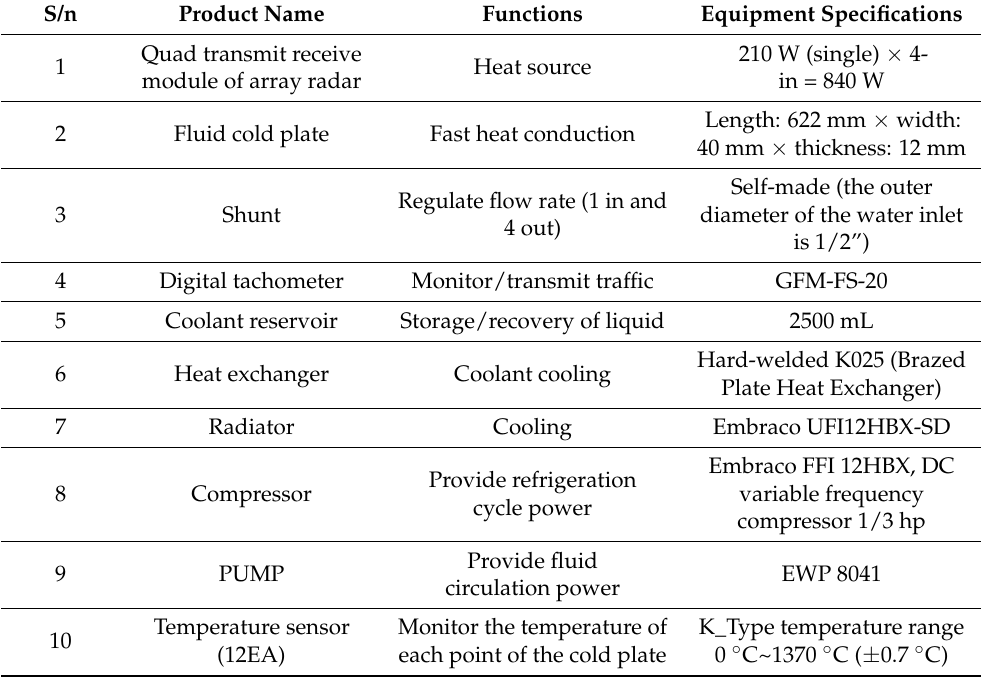
Figure 11. Hardware configuration of the fluid circulation heat dissipation system module. Table 6. Performance specifications for each piece of